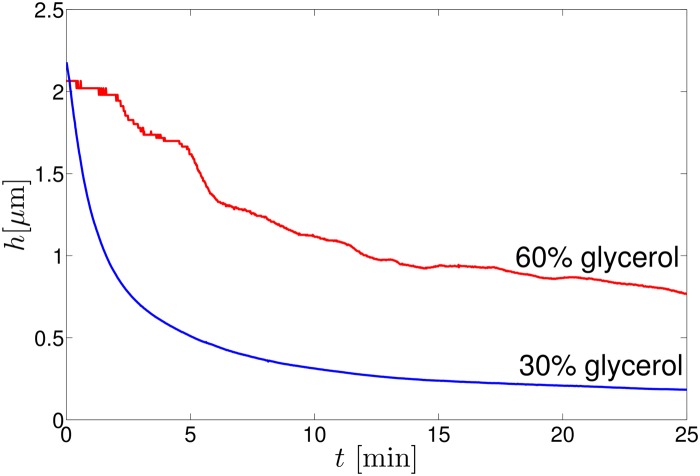
Thickness as a function of time, which decreases due to soap film drainage, for films with weight percent glycerol as indicated.